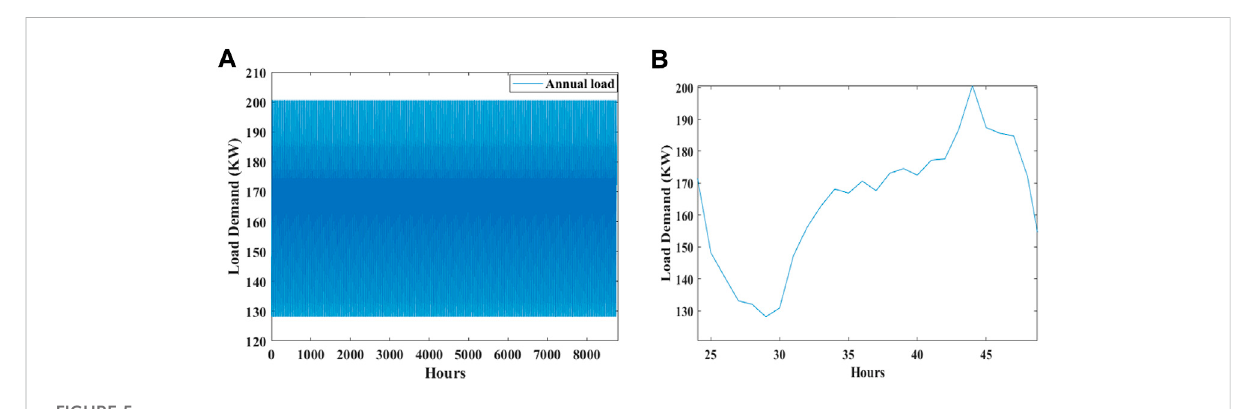
FIGURE 4 The pseudocode for the GWO and for the GWCSO.